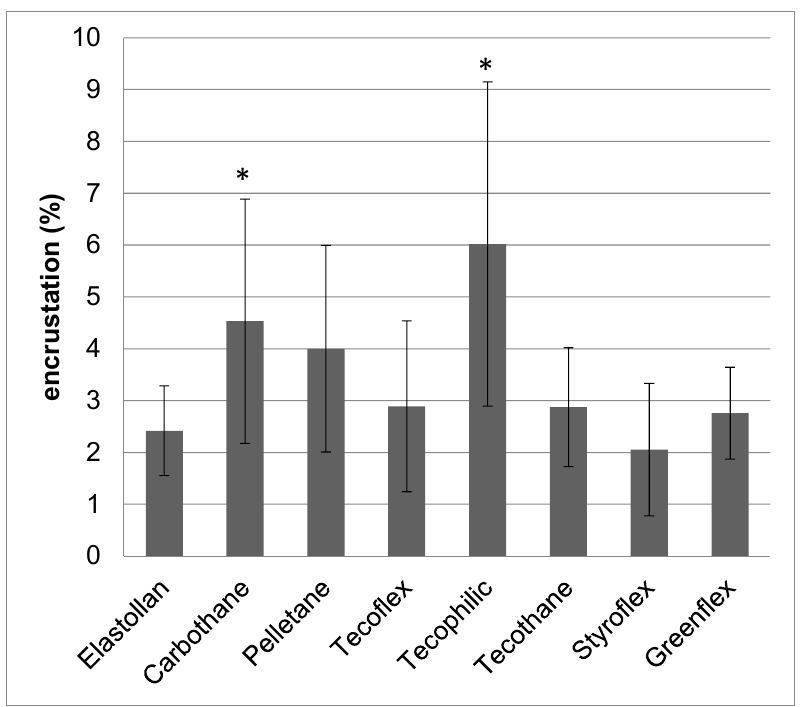
Figure 4. Quantification of encrustations on polymer bulk materials after 5 d in the in vitro encrustation system. n ≥ 3. mean ± s.e.m., statistics: Kruskal–Wallis post hoc, uncorrected Dunn’s test, * p < 0.05 compared to Elastollan.